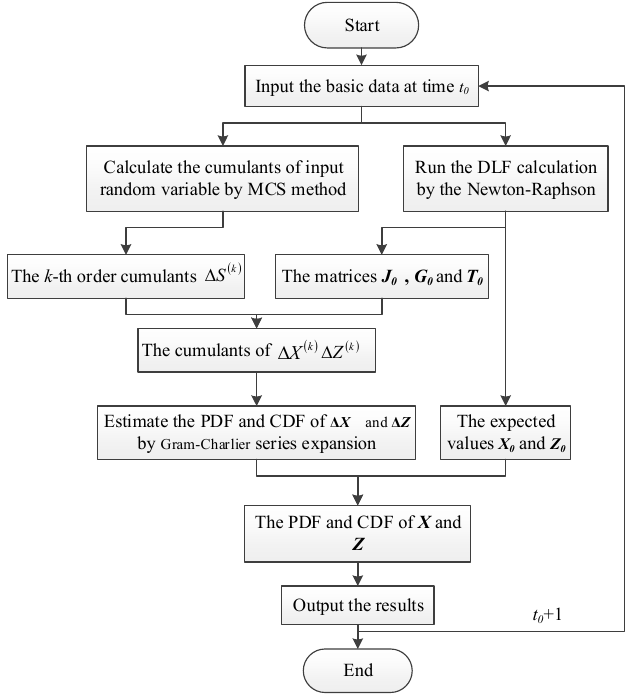
Figure 1. The flowchart of PLF based on cumulants and Gram ‐ Charlier series.